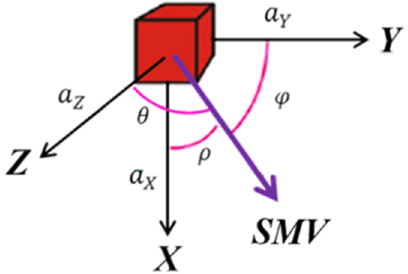
Figure 7. Angles between the signal magnitude vector (SMV) and the three axes.